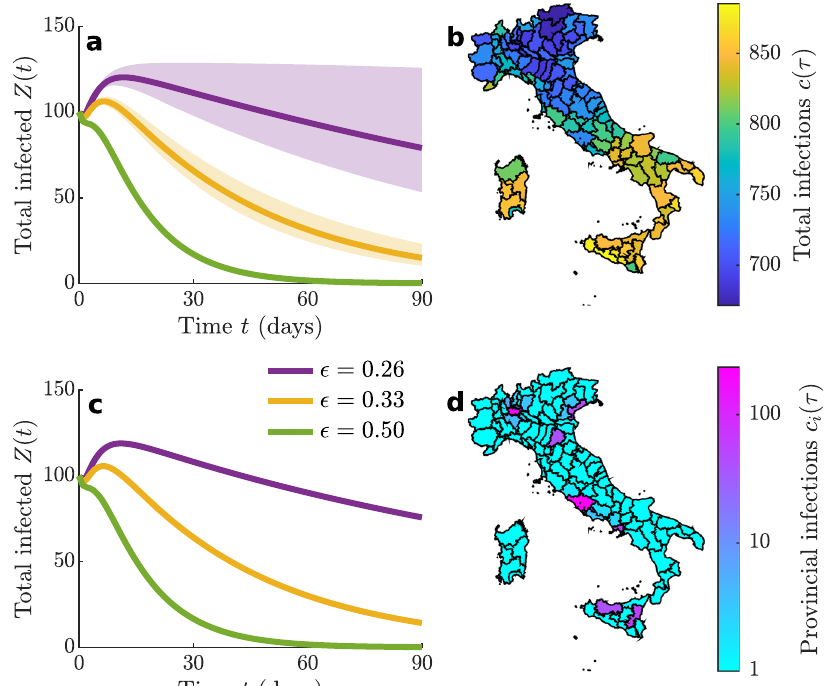
Fig. 4 The effect of initial conditions and of containment measures on subthreshold epidemics in Italy. The SEPIAR model has been numerically integrated for a timespan τ = 90 days starting from different initial conditions, while assuming that spatially homogeneous containment measures are in place from the beginning of the epidemic. a Total number of infected individuals in the community, evaluated as Z ð t Þ ¼ ∑ n i outbreaks started by seeding one by one each of the 107 Italian provinces (solid lines: across-province median; shadings: min-max envelope) with an initial number of exposed individuals E i (0) = 100, assuming an otherwise fully susceptible population ( S i (0) = N i − E i (0)). b Provinces in the map are color-coded according to the cumulated number of cases over the whole national territory up to the end of the simulation timespan for a subthreshold epidemic seeded in the considered province and for the intermediate-control scenario (yellow) of ( a ). c Same as ( a ) for a simulated outbreak obtained by seeding the provinces where the ten busiest Italian airports are located ( “ Methods ” ). A total number of 100 exposed individuals has been allocated proportionally to the total passenger fl ux at the beginning of the simulation. d Map of the projected infections in each province up to the end of the simulation period for the intermediate-control scenario (yellow) of ( c ). Parameters as in Table 2, with ϵ i = ϵ (numerical values are given in c ), ξ ij = 0.5, and χ X i ¼ 0 : 1 days − 1 for all i ’ s, j ’ s, and X ∈ { E , P , I , A }. For the three combinations of the control parameters shown in a and c , we fi nd R 0.50, respectively, with e c (evaluated for w X = 1, X ∈ { E , P , I , A }) ≈ 0.13, 0.099, and 0.017 day − 1